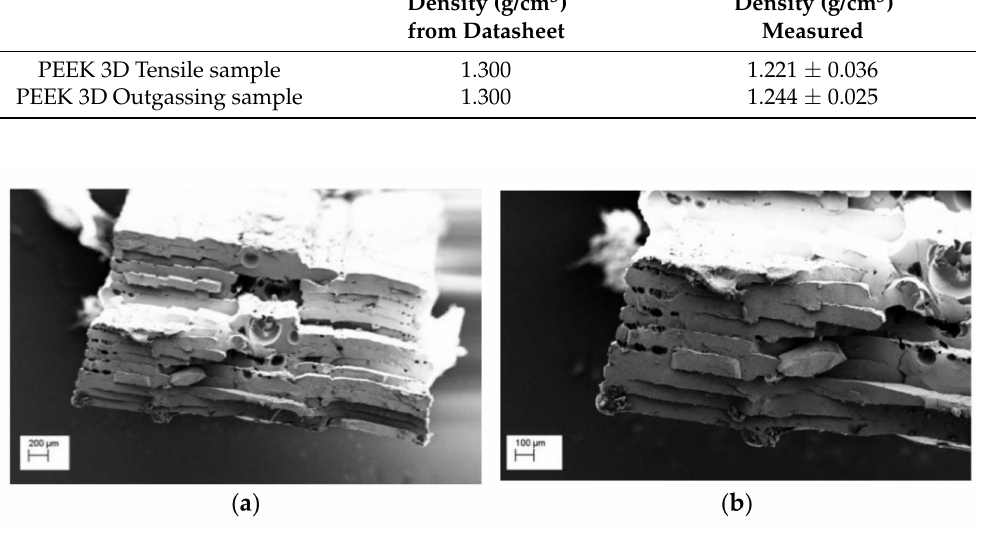
Figure 7. SEM micrograph of 3D-printed PEEK tensile specimen ( a ) low magnification ( b ) high